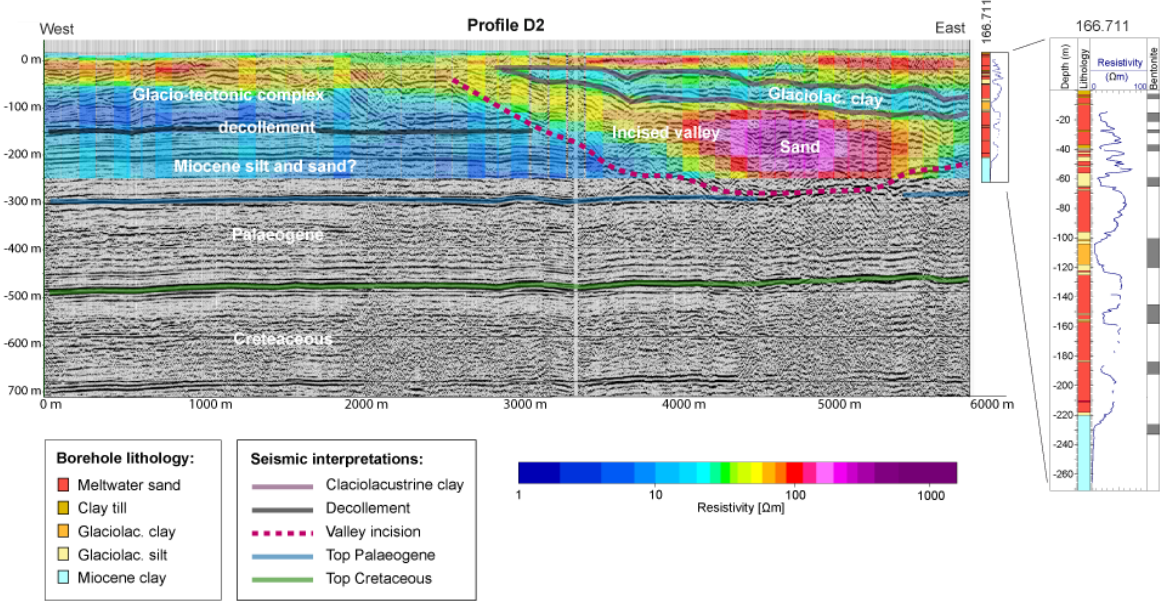
Fig. 7. Interpreted seismic section (profile D2) with SkyTEM resistivity data showing glaciotectonised Miocene and Pleistocene layers and the same deep, buried tunnel valley as shown on profile D4. Lithology and an IN log from a borehole (archive no. 166.711, GEUS, 2012) located approximately 160m in the eastward extension of the seismic section are also shown on the profile. Interference by bentonite plugs (shown on right of induction log) in this well produces false low-resistivity values at distinct intervals on the IN log, but an overall good match between the lithology and the log results is seen. For location of the section, see Figs. 5 and 10. Vertical exaggeration 3 ×